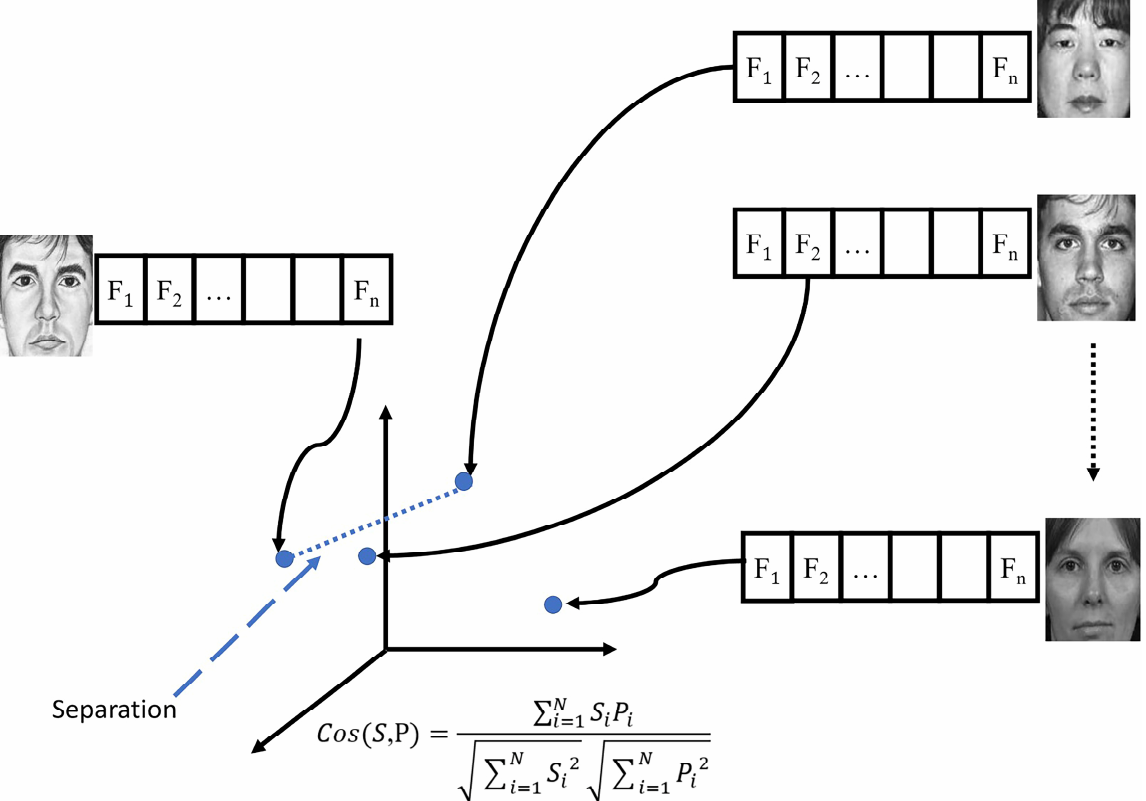
Figure 8. Description of separation